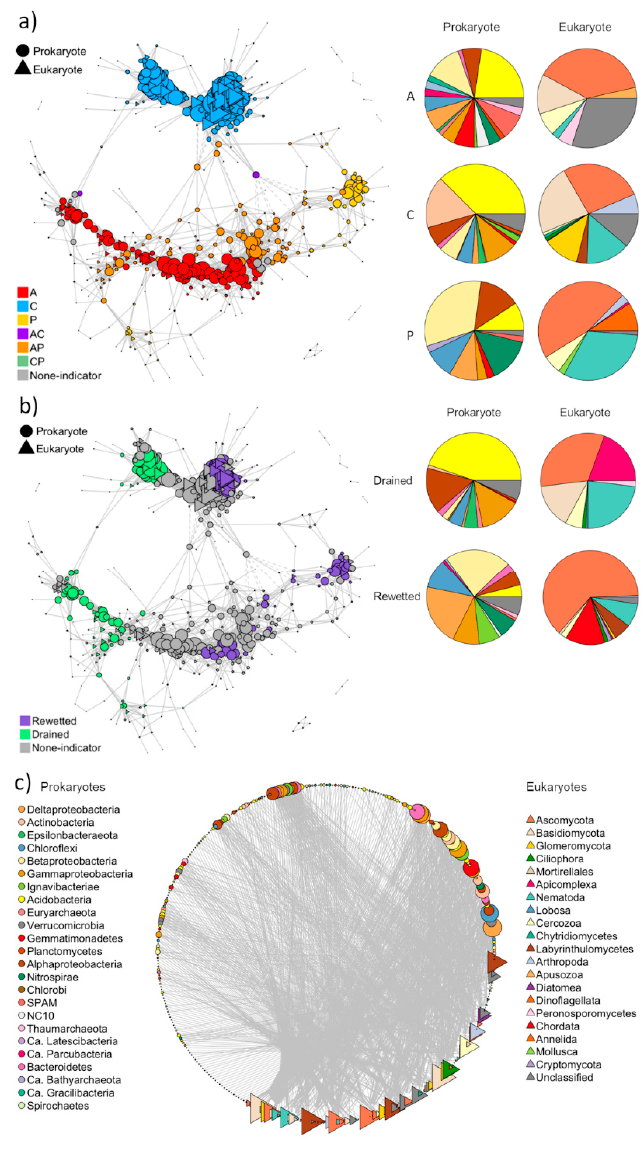
Figure 5. Co-occurrence networks. ( a ) Co-occurrence network of indicator ASVs associated with (A) alder carr, (C) coastal fen, and (P) percolation fen, or with both alder carr and coastal fen (AC), both alder carr and percolation fen (AP), and both coastal fen and percolation fen (CP). ( b ) Co-occurrence network of indicator ASVs associated with drained and rewetted sites. ( c ) Co-occurrence network showing connections between prokaryotic and eukaryotic ASVs. ASVs with relative abundances lower than 0.05% were discarded. ASVs were identified as indicators associated with fen type or water condition using the indicspecies package [45], and are color-coded according to fen type and water condition (drained/rewetted) in ( a ) and ( b ), respectively. The relative abundances of prokaryotes and eukaryotes associated with the different fen types and water conditions are shown as pie charts on the right side of ( a ) and ( b ), respectively. The color code in pie charts of ( a ) and ( b ) correspond to the color code in ( c ). Solid lines indicate significant positive Spearman’s rank correlations (R > 0.7. p < 0.01), while dashed lines indicate significant negative correlations (R < − 0.7. p < 0.01). Nodes are sized according to their degrees.